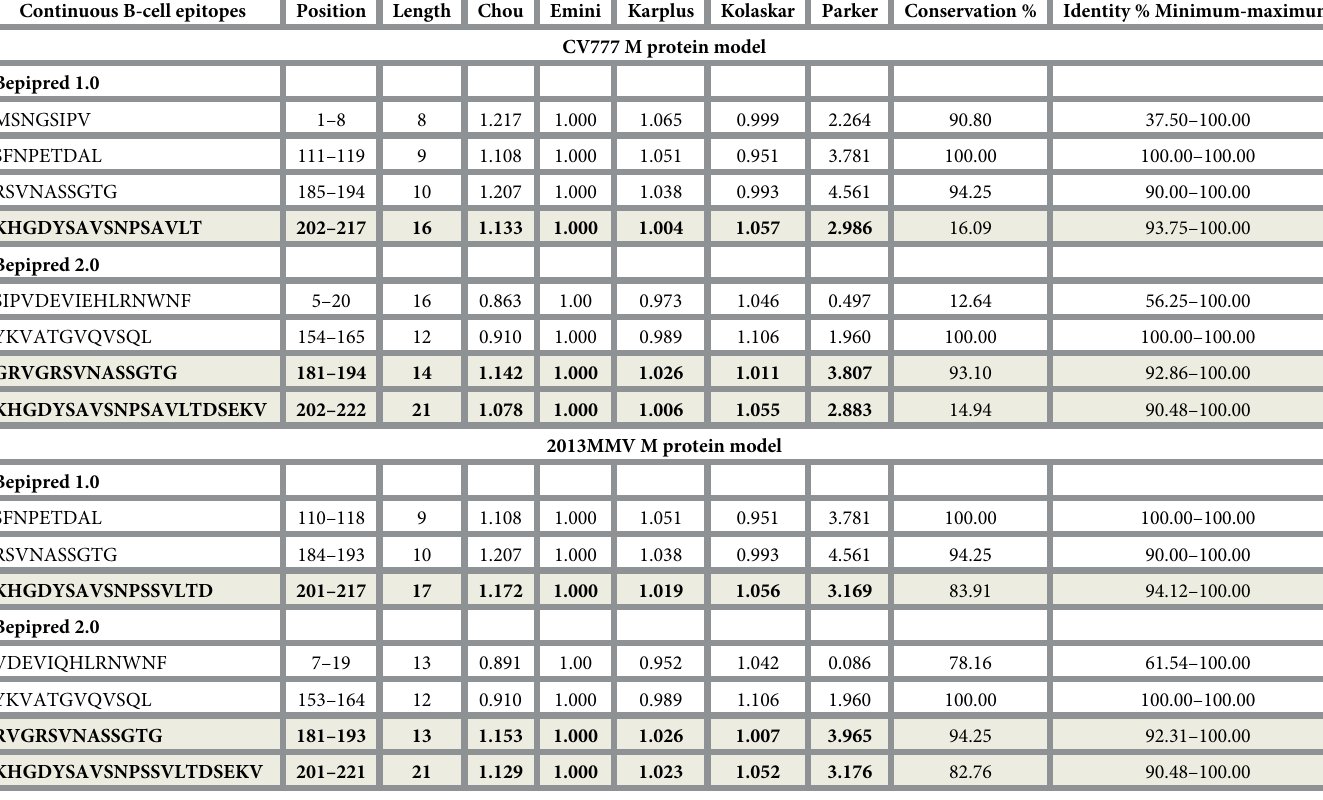
M protein from Feig lab models were 6.0 and 14.1 Å , respectively (S1B Fig). The RMSD values between 3D model of 2013MMV M protein with the SARS-CoV-2 M protein model from AlphaFold (S1C Fig) and with SARS-CoV-2 M protein model from Feig lab (S1D Fig) were 8.120 and 15.716 Å , respectively. While the superimposition of the SARS-CoV-2 M protein models from AlphaFold and Feig lab showed an RMSD of 12.6 Å (S1E Fig). The main difference between all the models was observed in the α -helix on the transmembrane region and the spatial arrangement of the globular region. The data obtained demonstrate that the 3D models of CV777 and 2013MMV M proteins generated by Robetta have good overall quality similar to the quality of the models of the SARS-CoV-2 M protein obtained by AlphaFold and Feig lab. Identification of linear B cell epitopes in the PEDV M protein model. The epitopes in the predicted 3D models of the PEDV M protein were analyzed. The B cell epitopes of the CV777 M and 2013MMV M proteins were predicted using servers BepiPred 1.0 (linear epitope prediction) and Bepipred 2.0 (sequential B cell epitope predictor). Both programs predicted four peptides in the CV777 M protein model; the B cell peptides RSVNASSGTG and KHGDY- SAVSNPSAVLT were predicted by both servers. The two peptides were above the threshold level of 1.0 (Table 1). In the 2013MMV M protein model, 3 and 4 peptides were predicted by both servers, respectively. The KHGDYSAVSNPSSVLTD epitope was above the threshold level of 1.0 and was predicted by both servers. The peptides identified in the 3D models of the Table 1. Continuous B-cell epitopes of CV777 M